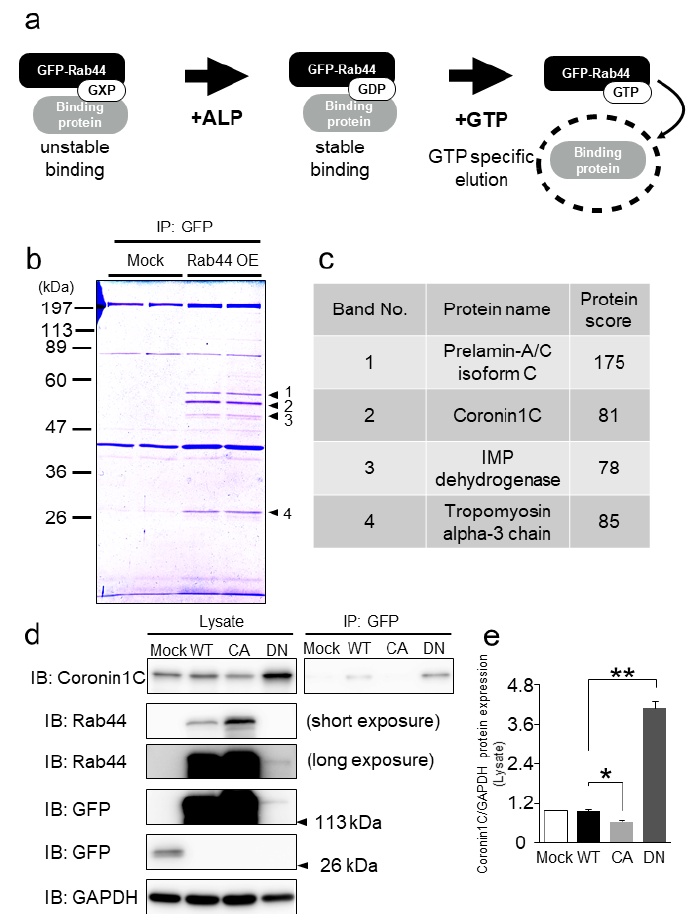
Figure 1. Identification of Coronin1C as a GDP-specific Rab44-interacting protein in mouse macrophage RAW-D cells. ( a ) Schematic of GDP-bound Rab44-interacting proteins. Rab44 binds to and dissociates from GEF in the presence of GTP or GDP (GXP) in cellular lysates (unstable binding). The addition of ALP (25U) removed GXP and maintained the binding between GEF and Rab44 (stable binding). When GTP (5 mM) was added, GDP-specific Rab44 interacting proteins were extracted (GTP-specific elution). ( b ) CBB staining of the GDP-bound Rab44-interacting proteins. Immunoprecipitation (IP) was performed using beads with GFP antibody in RAW-D cells expressing GFP protein only (mock) or Rab44 tagged with GFP (Rab44 OE). The eluates (same protein amounts) were subjected to SDS-PAGE detected by CBB staining. ( c ) The four proteins were identified by MALDI-TOF-MS using Mascot Search. Prelamin-A/C was detected as band #1, Coronin1C was band #2, IMP dehydrogenase was band #3, and Tropomyosin α 3 chain was band #4. Protein scores greater than 65 were considered significant ( p < 0.05). ( d ) Western blot analysis of immunoprecipitation (IP) experiments with GFP antibody in RAW-D cells expressing GFP protein only (Mock), Rab44 tagged with GFP (WT), a constitutively active (CA) mutant (Q596L), and a dominantly negative (DN) mutant (T551N). Cell lysates or IP samples using a GFP antibody were subjected to SDS-PAGE followed by Western blotting with antibodies against Coronin1c, Rab44, GFP, and GAPDH. GAPDH was used as the loading control. ( e ) Quantitative analysis of proteins in cell lysates by relative chemiluminescence intensity measured with ImageJ. Measurements were normalized to those of mock without RANKL stimulation. * p < 0.05, ** p < 0.01; compared to WT with or without RANKL stimulation,